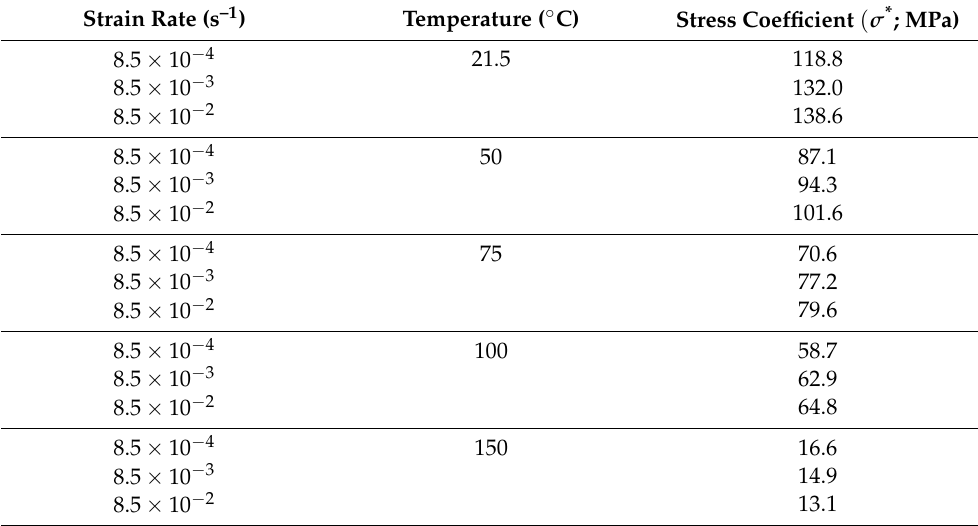
Table 5. Stress coefficient for CFRP at different strain rates and temperatures.